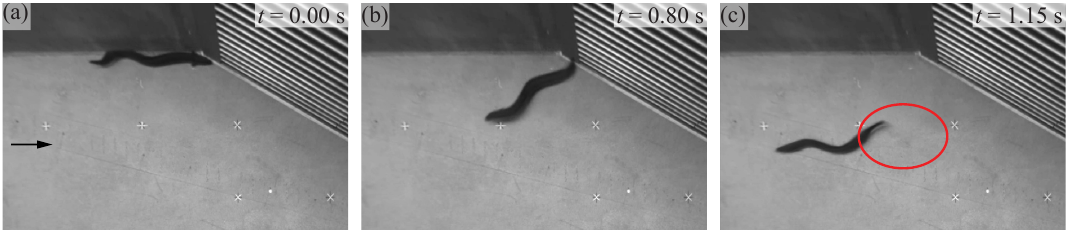
Figure 14. An eel ( Anguilla anguilla ) with TL = 61 cm ( a ) approaching the electrified horizontal bar rack with negative rheotaxis and ( b ) escaping upstream, while ( c ) losing a dark fluid (encircled) after having been exposed to rather large voltage gradients at the upstream rack